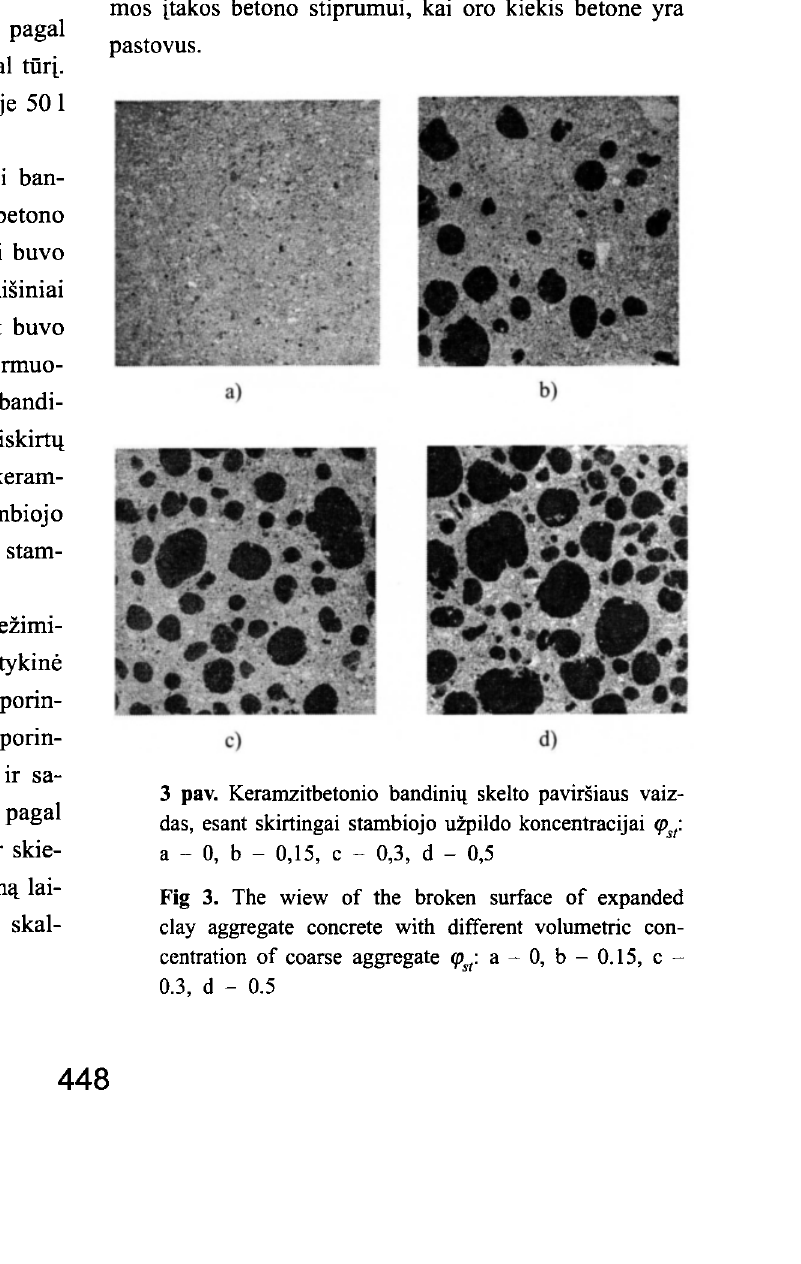
Fig 3. The wiew of the broken surface of expanded clay aggregate concrete with different volumetric con centration of coarse aggregate qJs 1: a - 0, b - 0.15, c - 0.3, d -